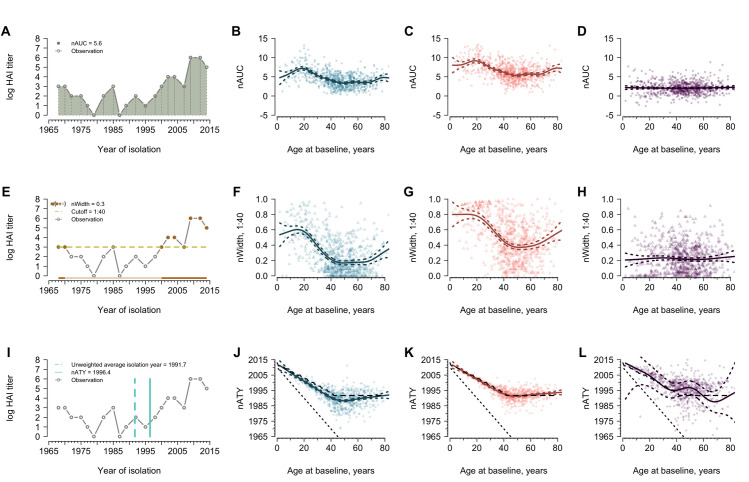
The normalized area under the curve (nAUC), width above 1:40 (nW40) and average titer years (nATY) varying with age.Metrics were calculated using post-birth strains and normalized by the number of post-birth strains. Blue and red represent the metrics measured for serum collected from baseline and follow-up visit, respectively. Purple indicates the differences in metrics between the two visits. Solid lines are predictions from a generalized additive model and the colored dashed lines represent the corresponding 95% confidence intervals. (A) Demonstration of nAUC for one participant as an example. The same participant, who was aged 73 years old at baseline, is used for panel E and I. (B) Age and nAUC at baseline. (C) Age and nAUC at follow-up. (D) Age and changes in nAUC between the two visits. (E) Demonstration of nW40 for one participant as an example. Solid points are the years that contributed to calculating width. (F) Age and nW40 at baseline. (G) Age and nW40 at follow-up. (H) Age and changes in nW40 between the visits. (I) Demonstration of nATY for one participant as an example. (J) Age and nATY at baseline. The sloping black dotted lines indicate the year of birth of participants and the black dashed lines indicate the unweighted average isolation year of post-birth strains given age on x-axis (same for panel K and L). (K) Age and nATY at follow-up. (L) Age and changes in nATY between the visits.